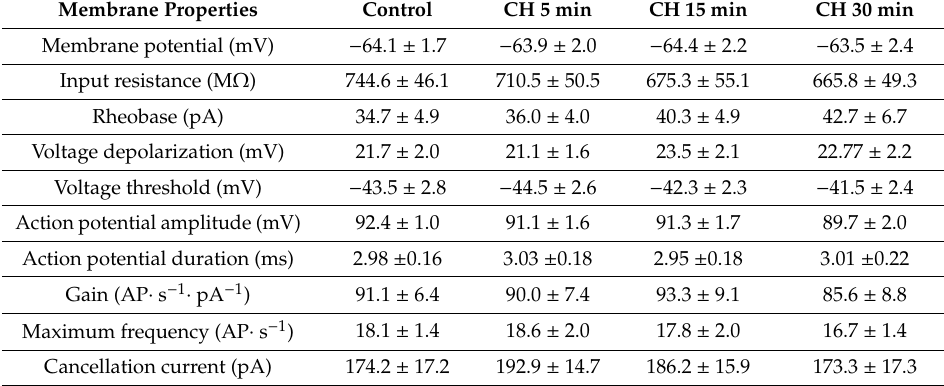
Table 1. E ff ects of cumene hydroperoxide (CH) on the electrophysiological properties on the pyramidal motor cortex neurons of newborn